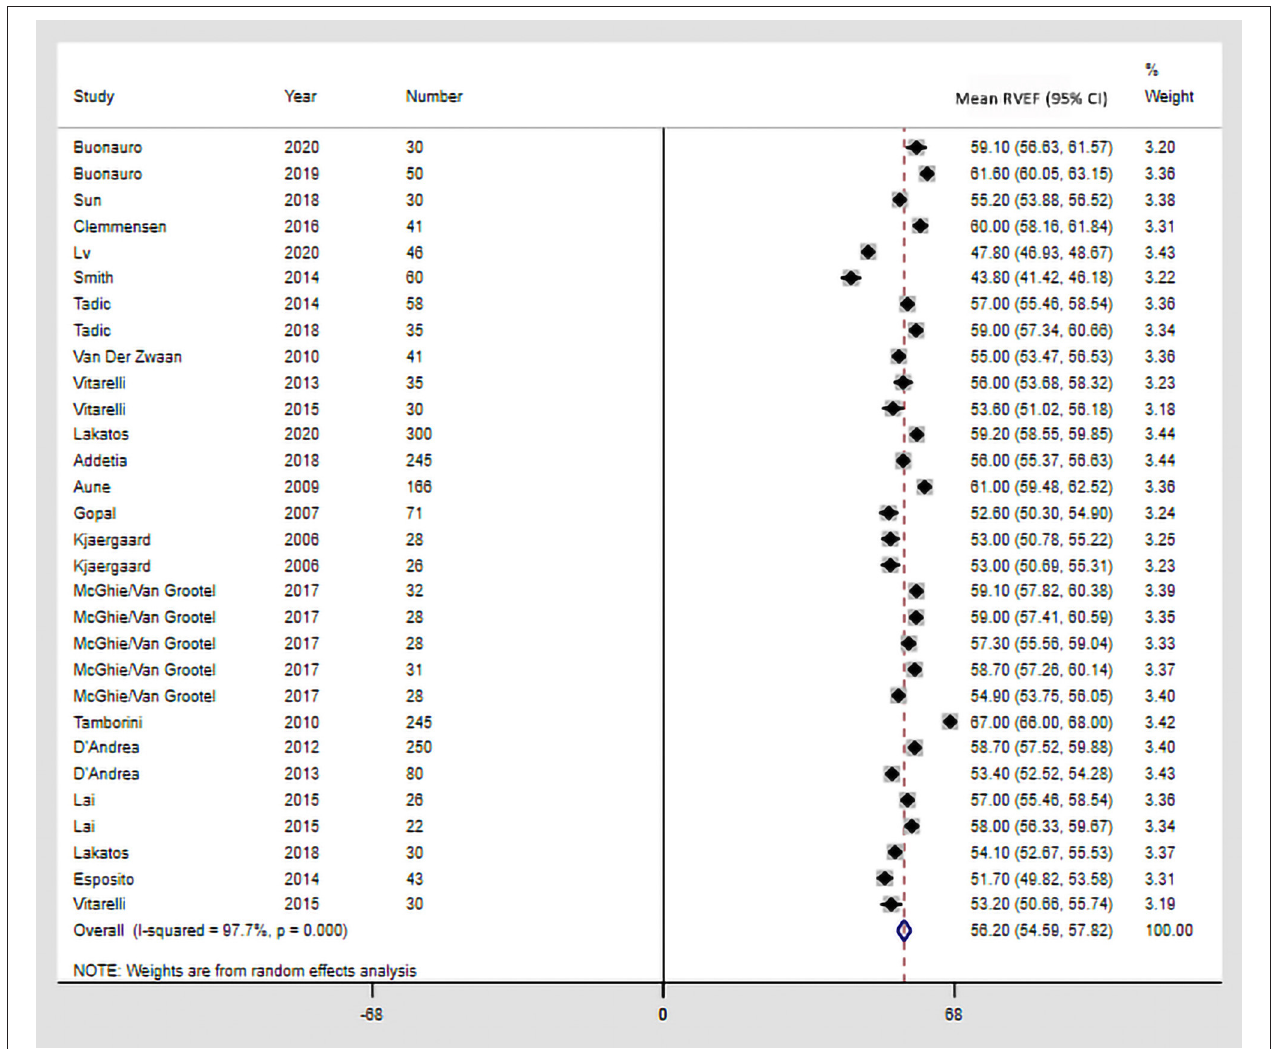
FIGURE 2 | Reference values of RVEF by 3DE. The square represents the mean of the point effect estimate of each study. The square size indicates the weight of the study. The horizontal line extending from either side of the square represents the 95% CI. The diamond reflects the pooled overall consequence. 3DE, three-dimensional echocardiography; CI, confidence interval; RVEF, right ventricular ejection fraction.